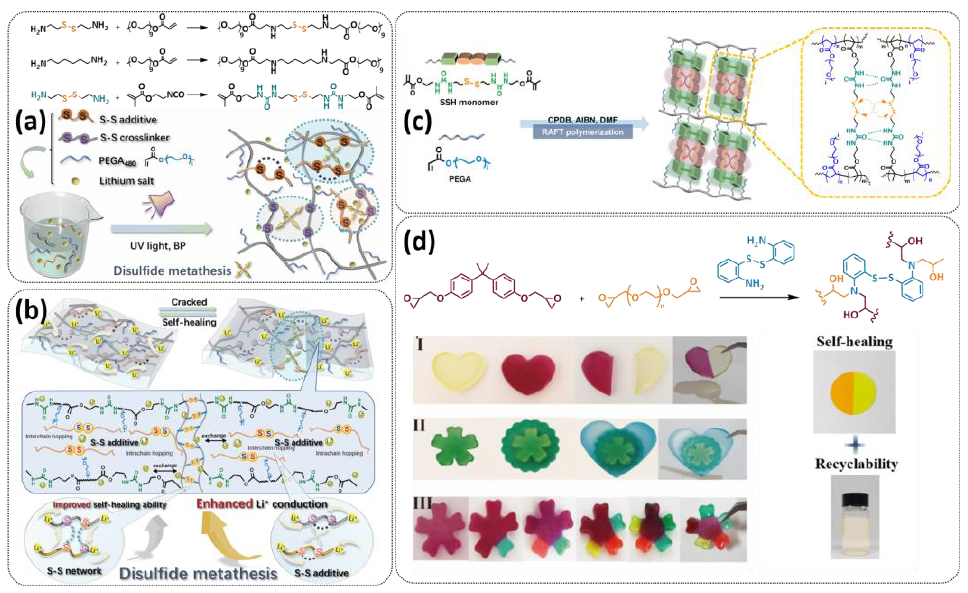
Figure 7. ( a ) Schematic illustration of the fabrication of polymer electrolytes with disulfide bonds (ICEPEs). ( b ) Schematic illustration of lithium-ion conduction, disulfide metathesis and the self- healing process. Reproduced with permission from [84]. Copyright © 2022, American Chemical Society. ( c ) Schematic illustration of the formation of PEG-SSH containing disulfide bonds and hydrogen bonds. Reproduced with permission from [75]. Copyright © 2020, American Chemical Society. ( d ) Schematic illustration of the preparation process and design of self-healing and recyclable polymer electrolyte RFSPE-3 and its self-healing behavior. Reproduced with permission from [83]. Copyright © 2021 Elsevier Ltd. All rights reserved.